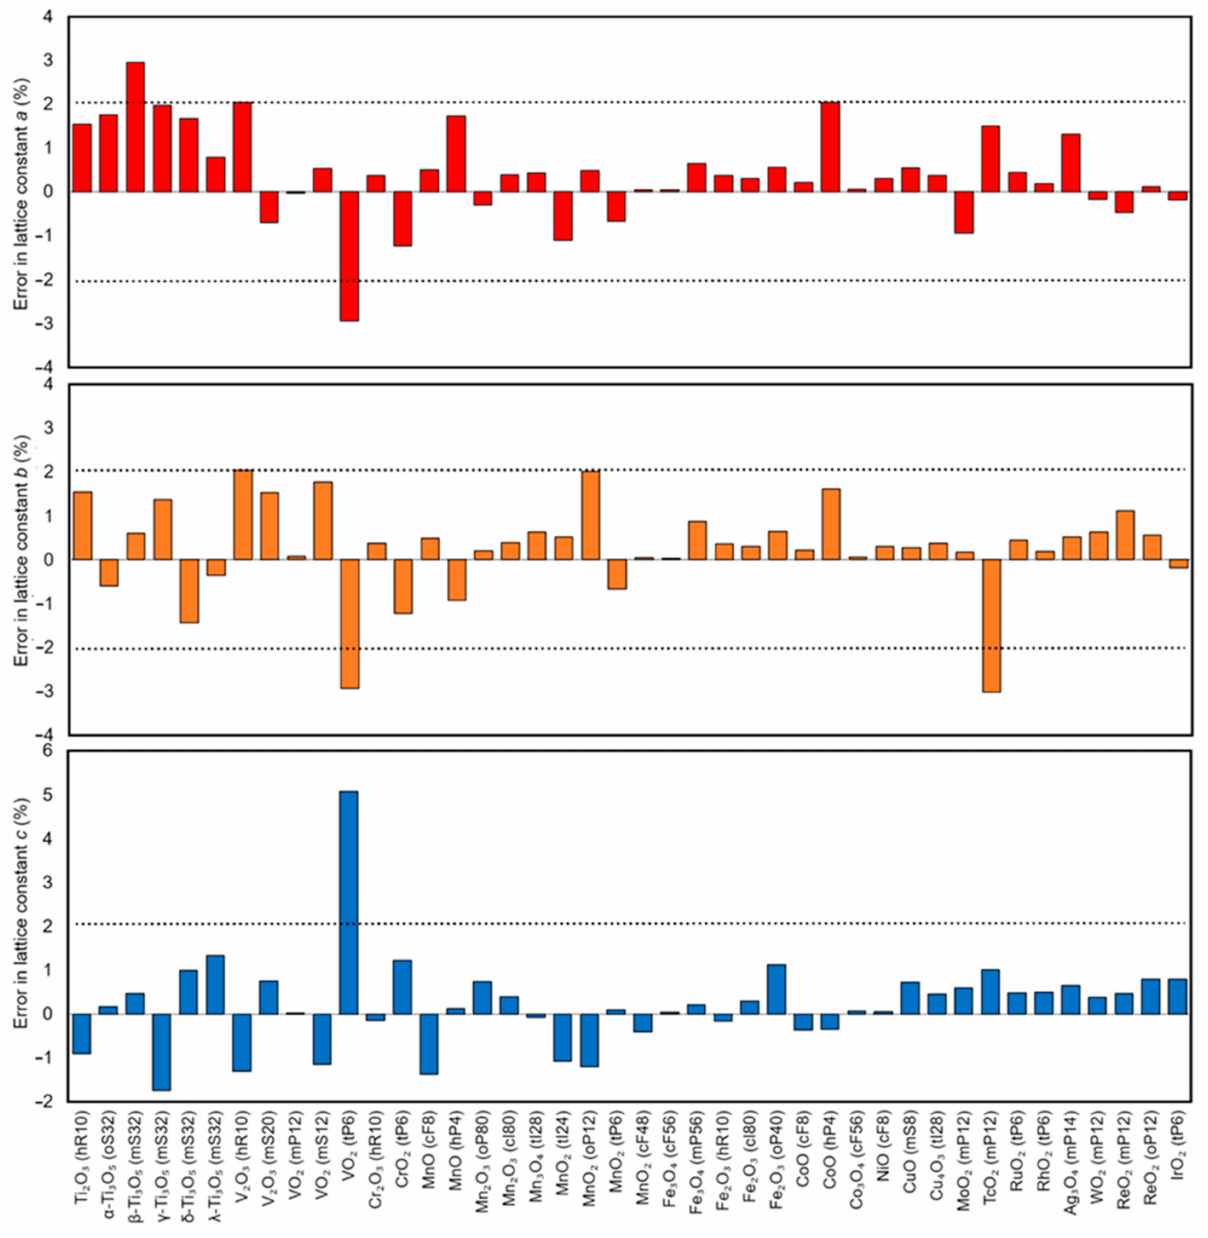
Figure 1. Errors in the optimized DFT-PBE0/TZVP lattice constants in comparison with the experi- mental lattice constants of the studied magnetic d -metal oxides. ReO 2 ( tP 6) is not included in the plot (see text for